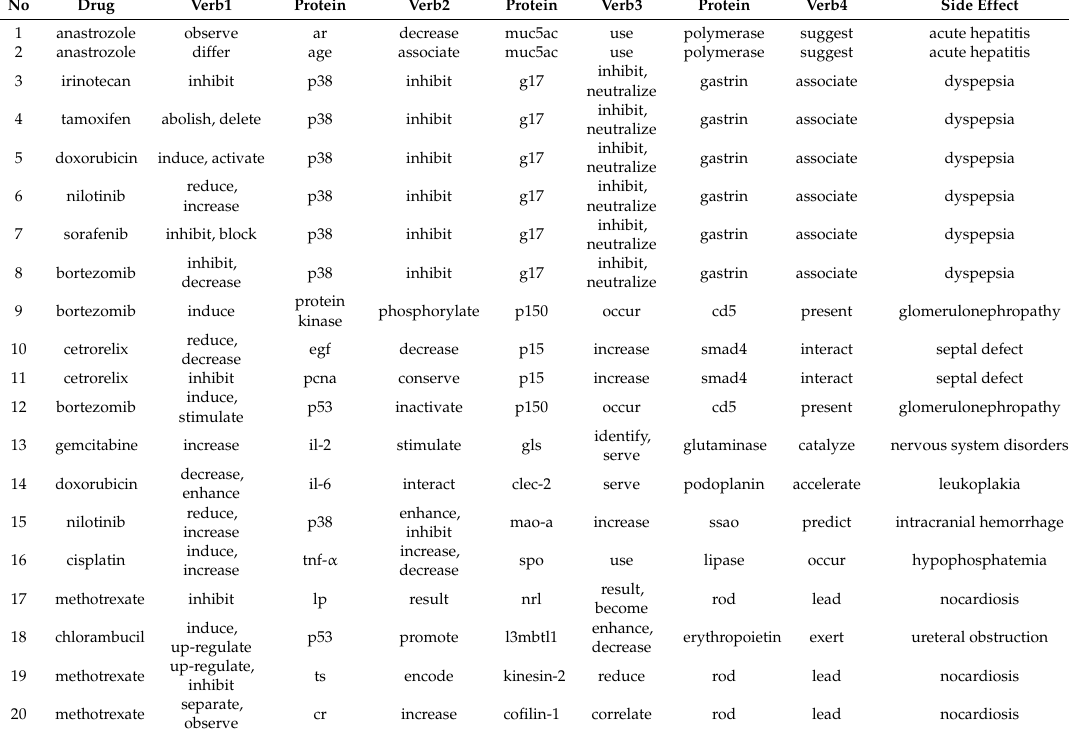
Table 4. List of top 20